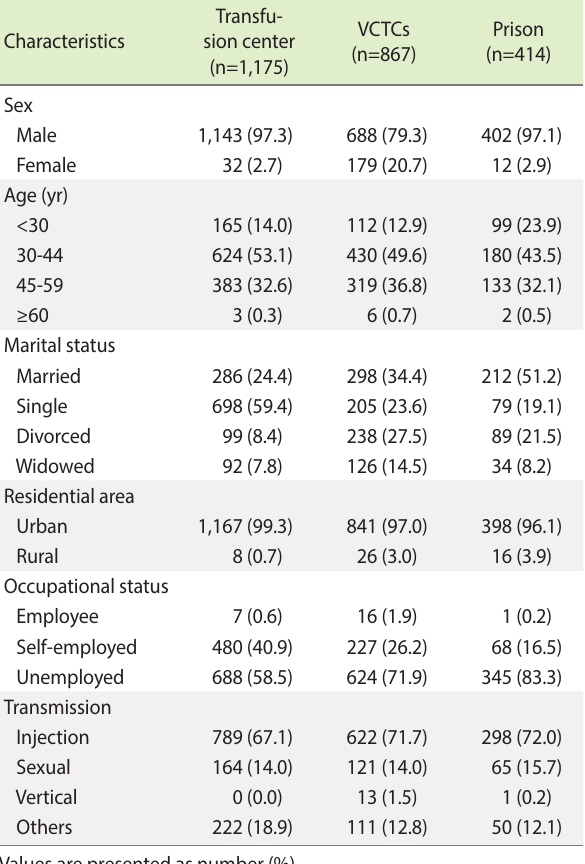
Table 1. The distribution of the demographic characteristics of the